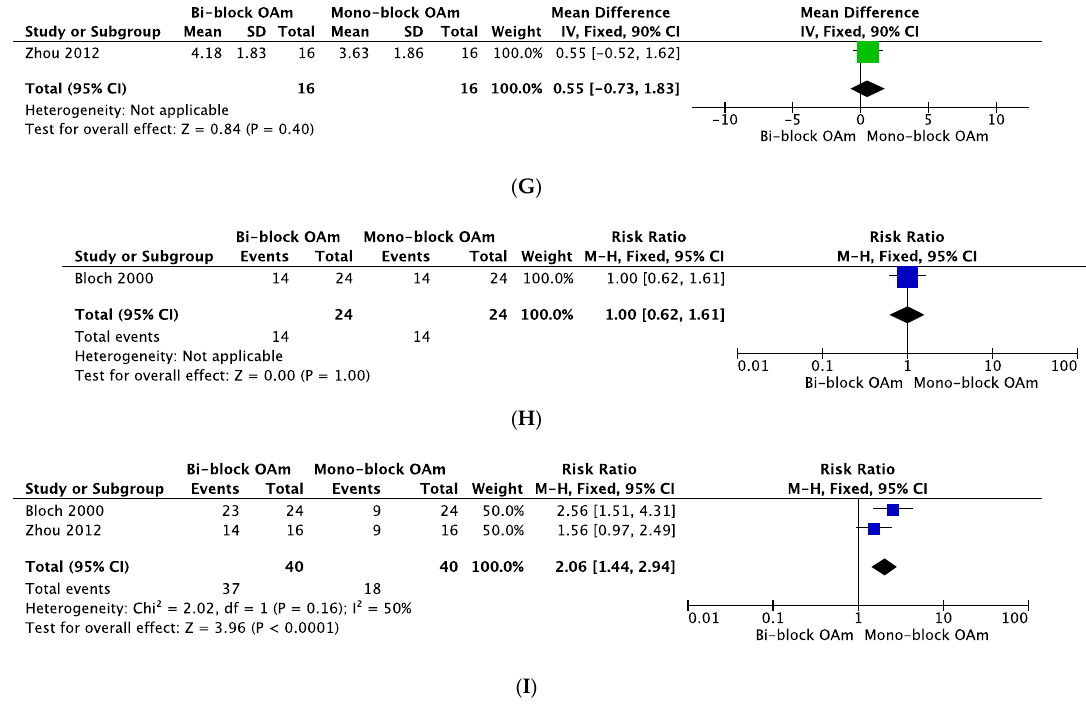
Figure 5. Forest plots of comparisons: Mono-block OA m versus Bi-block OA m . Outcomes: ( A ) AHI, ( B ) Lowest SpO 2 , ( C ) Arousal Index, ( D ) Non-REM stage 3, ( E ) Sleep efficiency, ( F ) ESS, ( G ) Snoring Scale, ( H ) Side effects, ( I ) Patient preference. OA m : Mandibular advancement type of oral appliance, AHI: Apnea–Hypopnea Index, ESS: Epworth Sleepiness Scale.